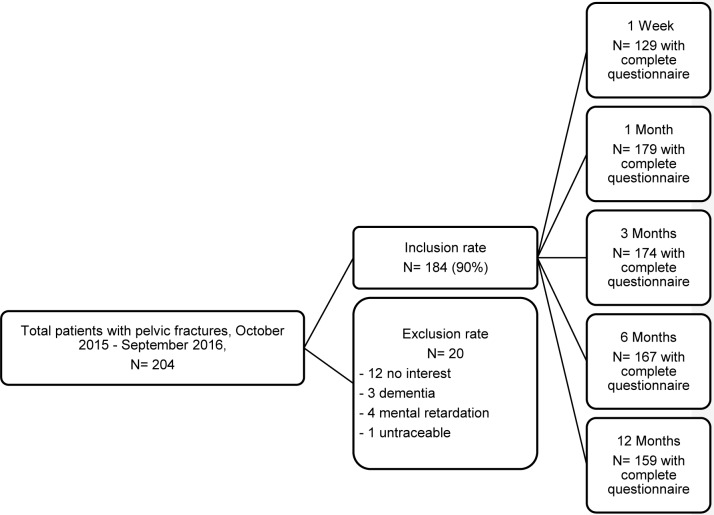
Flow of participants through the study.